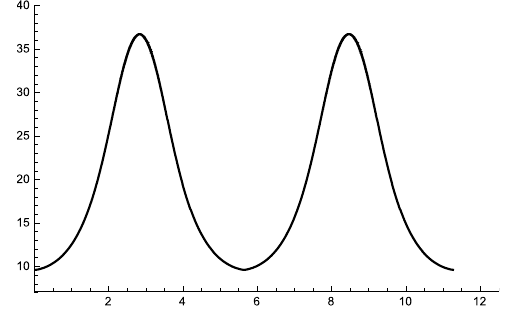
Figure 4 . Renormalised geodesic length for (cid:12)xed (cid:1) (cid:30) = 0 : 15 as a function time t + with di(cid:11)erent pressure on the shell. Parameter values are same as in (cid:12)gure 3 except (cid:11) = 0 : 995. For di(cid:11)erent values of (cid:11) , while keeping the other parameters same, the location of the upper turning point r + the shell changes. As a result the oscillation period is di(cid:11)erent. Geodesic lengths are also